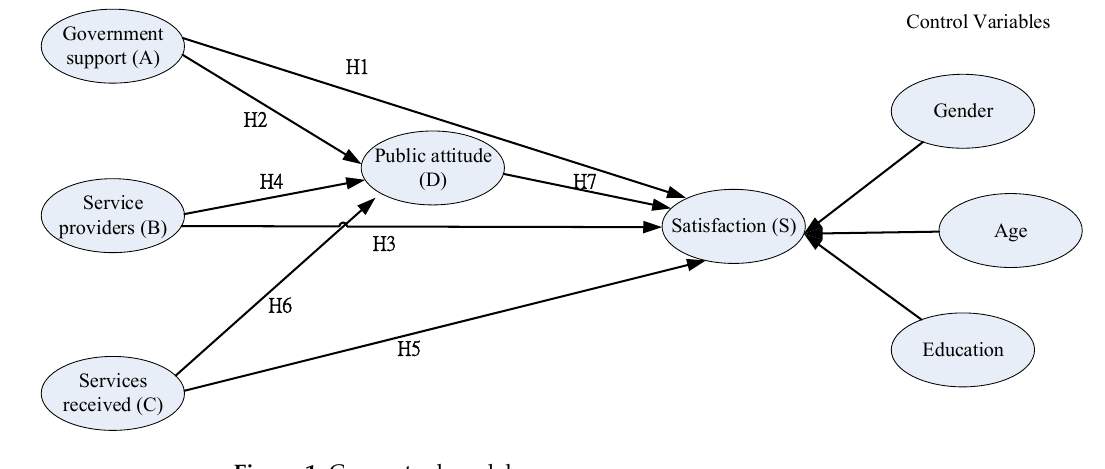
Figure 1. Conceptual model.